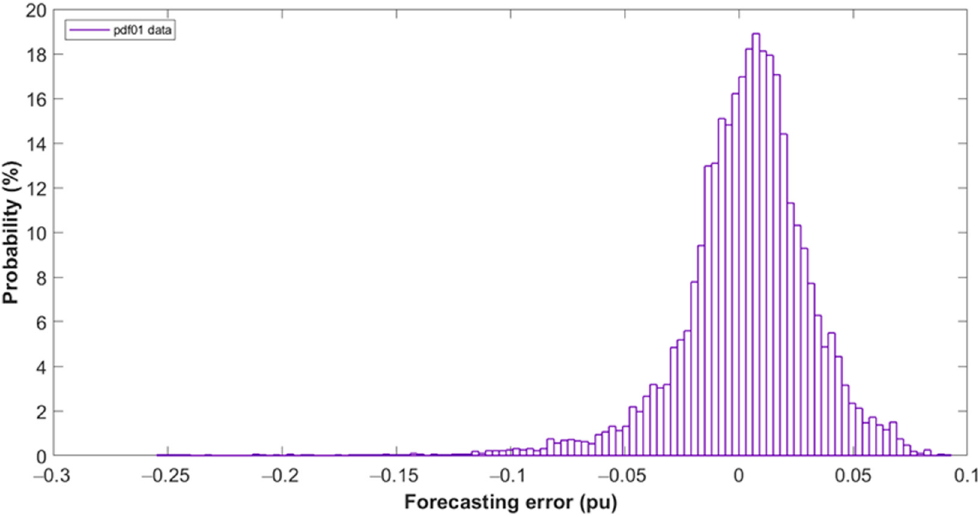
Figure 2. The forecasting error of wind power (spring) in the first interval (probability density function (pdf) 01).